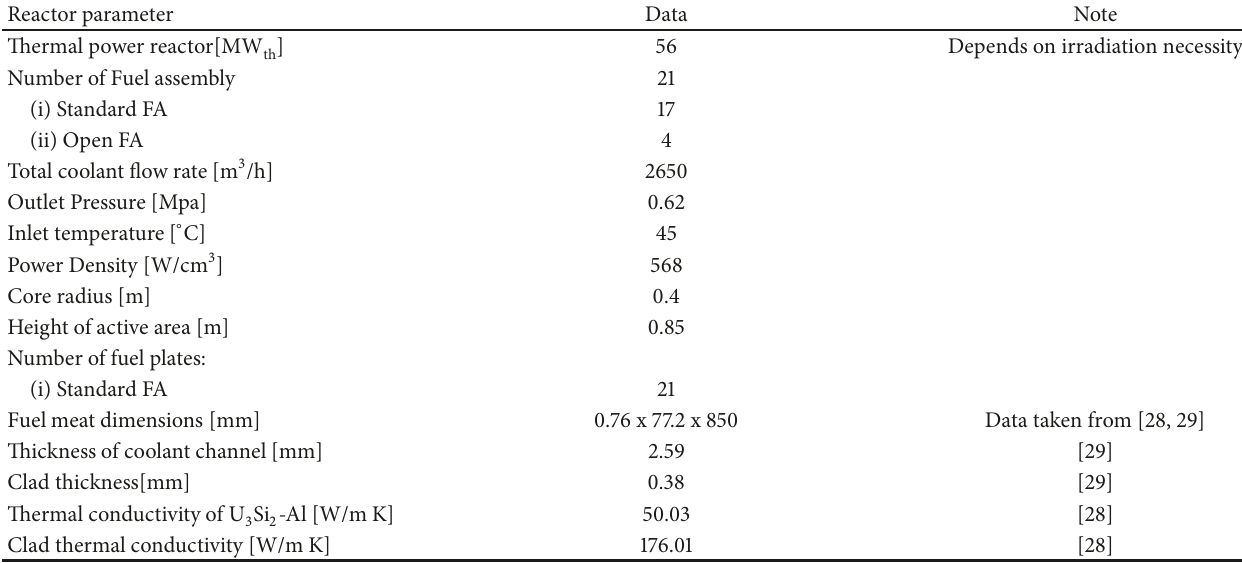
Table 6: Main operational and geometric parameters of CARR research reactor [7,